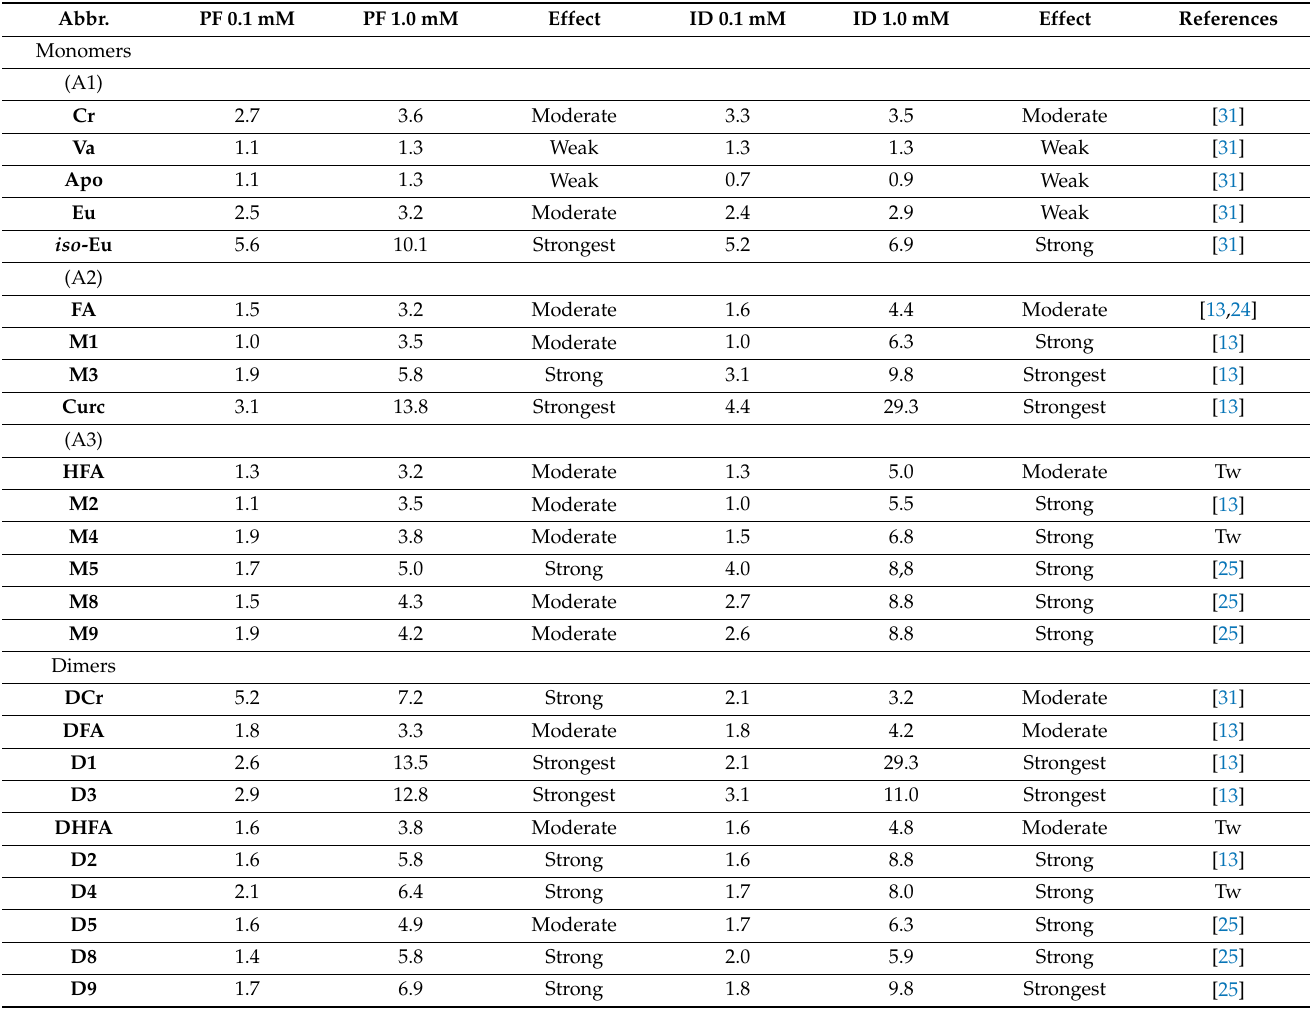
Table 2. Main kinetic parameters of chain-breaking antioxidant activity of the studied ortho -methoxyphenols (monomers and dimers) during lipid autoxidation.